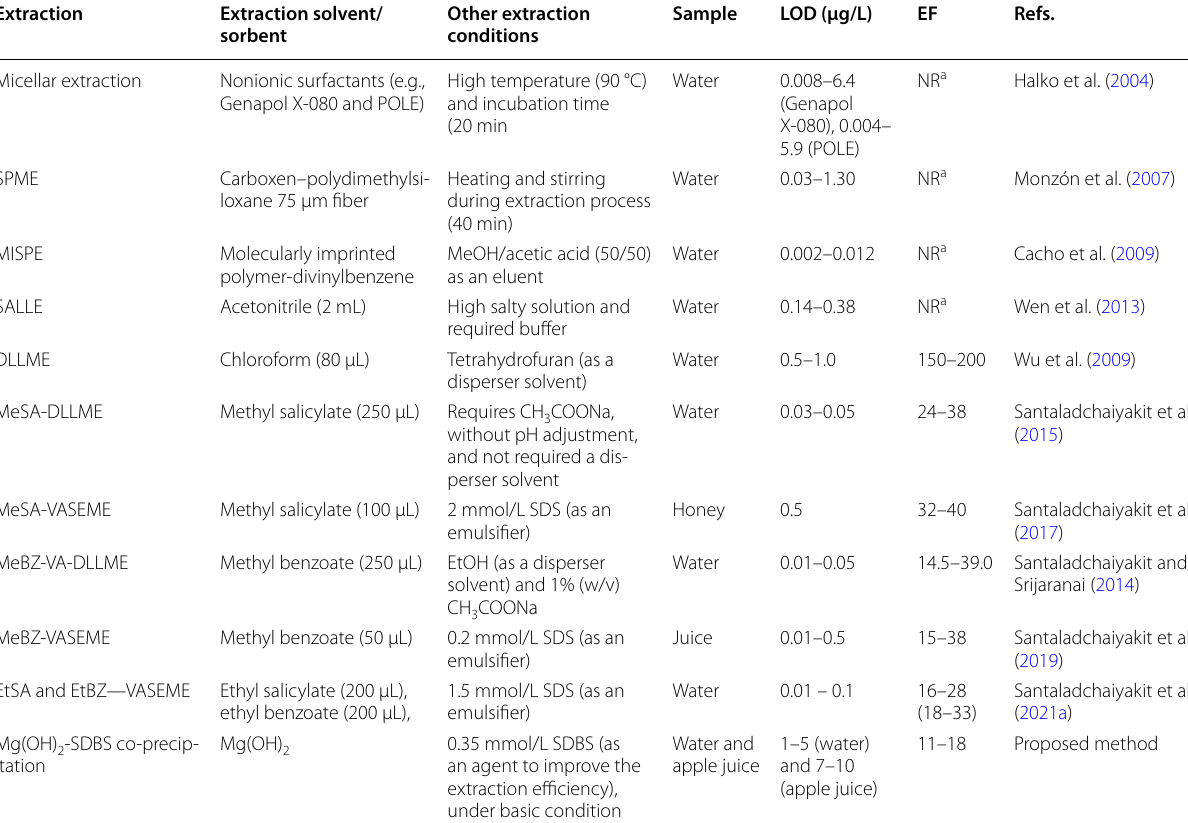
Table 5 The different preconcentration methods coupled with HPLC technique for the determination of benzimidazole fungicides in various sample